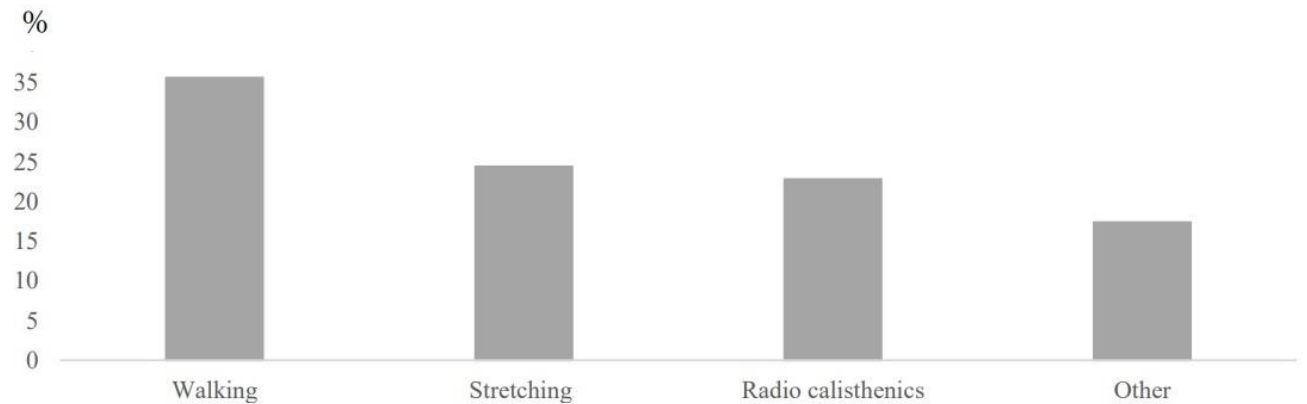
Figure 1. Assessment of the type of exercise during the COVID-19 pandemic state of emergency by the implementation of exercise during the declaration of a state of emergency containing one or more of the following was defined as the implementation of exercise: walking, radio calisthenics, stretching, other.